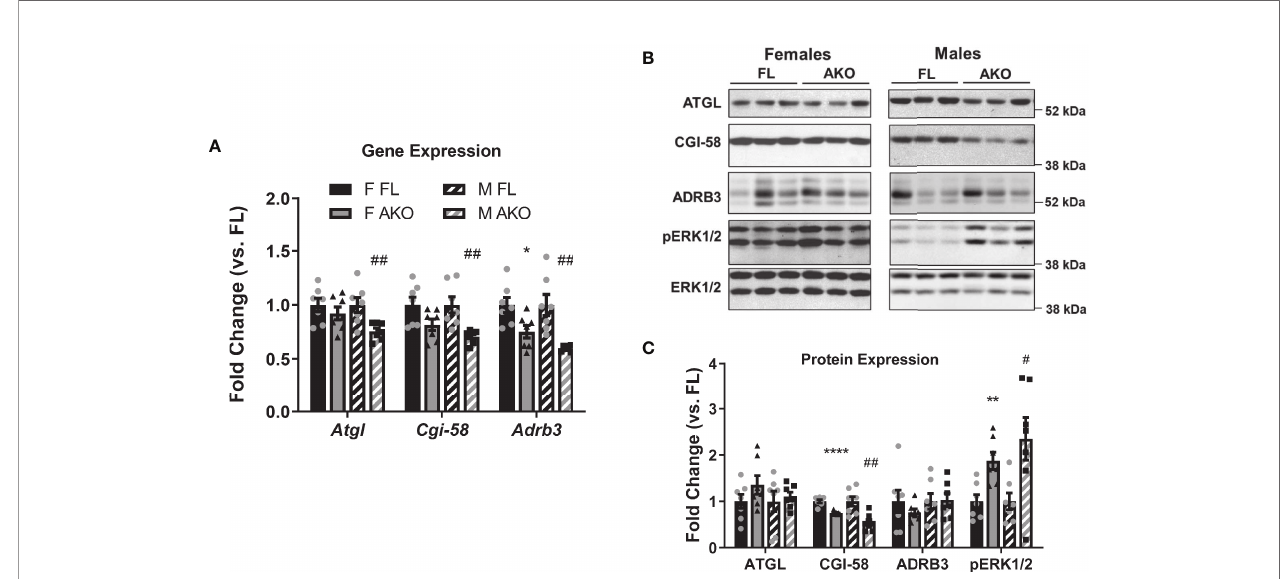
FIGURE 4 | Effects of loss of adipocyte STAT5 on expression of lipolytic proteins. Chow-fed female (F) and male (M) STAT5 AKO (AKO) and fl oxed (FL) littermate control mice were euthanized at 11 weeks of age (non-fasted), and subcutaneous iWAT was collected for gene (A) and protein (B, C) expression analyses. (A) Gene expression of Atgl/Pnpla2 , Cgi-58/Abhd5 , and Adrb3 was measured by RT-qPCR and normalized against the reference gene Nono . (B) Protein expression was examined by immunoblotting, and three representative samples per group are shown. (C) Band intensities were quanti fi ed and normalized against total ERK1/2 expression. Fold change was calculated as the relative gene or protein expression values divided by the mean value of the fl oxed control group of the same sex for each gene/protein (n = 7 per group). Signi fi cance was determined by t -test for FL versus AKO comparisons and is denoted as *p < 0.05, **p < 0.01, or ****p < 0.0001 for female comparisons, while signi fi cance for male comparisons is denoted as # p < 0.05 or ## p <